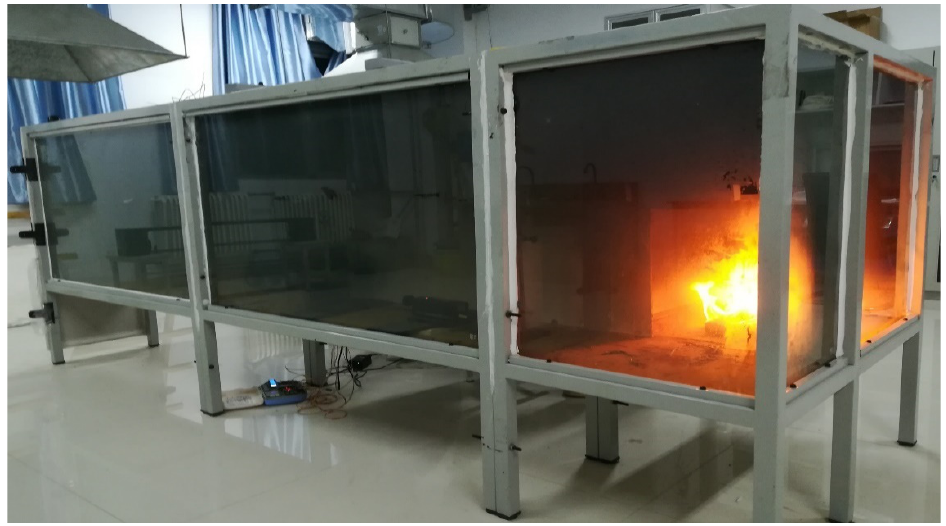
Figure 7. The photograph of the fire test room model.